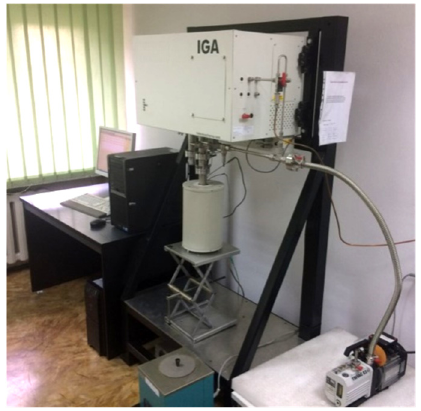
Figure 2. IGA-001 (intelligent gravimetric analyser) sorption test rig. Coal samples with a grain size of 0.2–0.25 mm and a mass of approximately 150 mg were used for sorption testing. In the first stage, the sample was degassed and heated at 98 °C to remove adsorbed impurities and moisture. 98 ◦ C to remove adsorbed impurities and